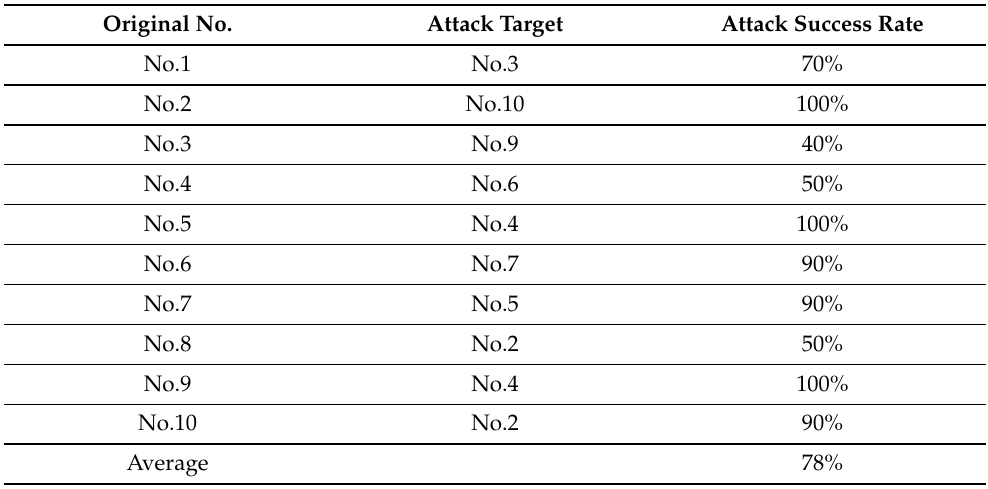
Table 12. In 22-person face recognition system, the attack success rate of a single target for imperson- ation attacks in the physical world.